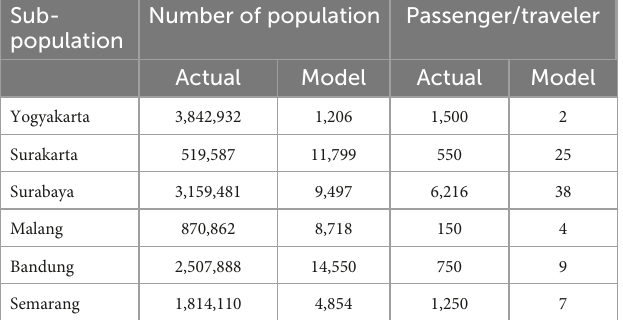
TABLE 2 Sub-populations and their number of air travelers to the main city of Jakarta (www.bps.go.id accessed 13 July 2020, www.flightradar24.com accessed 13 February 2021).